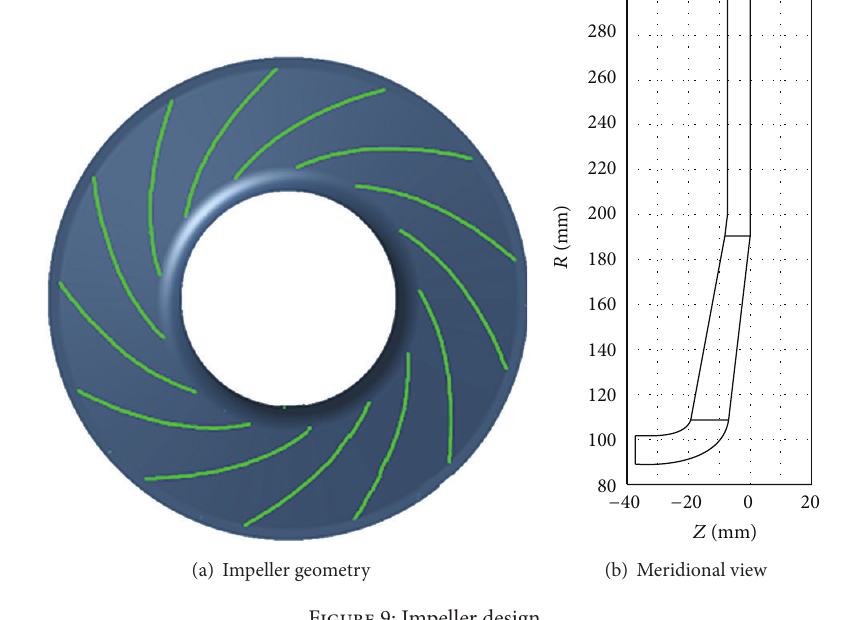
Figure 9: Impeller design.